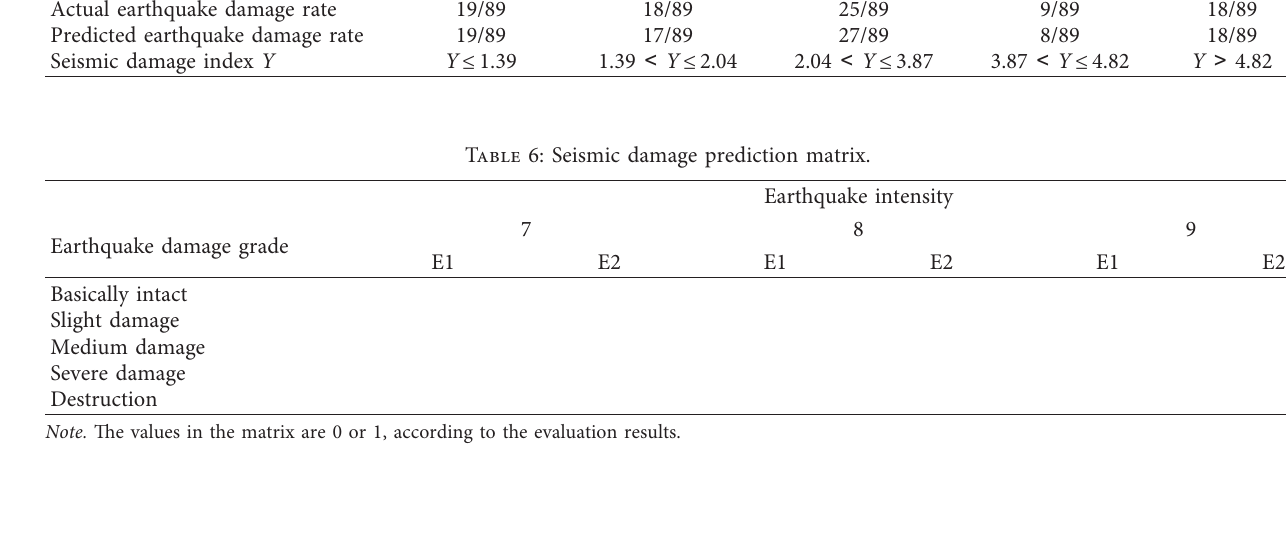
Table 7: Description of bridge damage at different